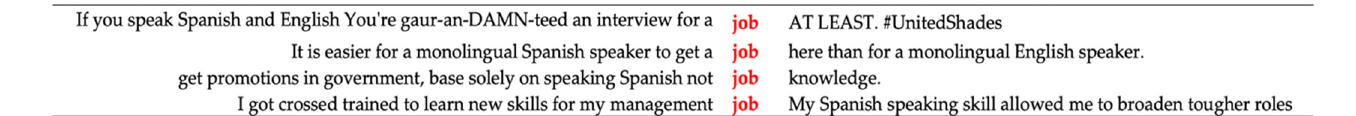
Figure 4. Concordance lines for trabajo that indicate positive attitudes on the status dimension. Figure 5. Concordance lines for trabajo that indicate negative attitudes on the status dimension. Notably, both corpora contain several frequently-occurring descriptors relating to the theme of politics—and specifically the 2020 US presidential elections—that indirectly allow us to draw conclusions regarding tweeters’ attitudes toward Spanish on the status dimension (see Table 1). These terms (e.g., election/elecciones , voters/votantes , and voting/vo- tación ) are relevant in this context because they make reference to the role that Spanish plays in politicians’ (re-)election by Floridians, as illustrated by the concordance lines in Figure 6. Figure 6. Concordance lines for vote that illustrate the role of Spanish in politicians’ (re-)election. Florida is one of the so-called battleground states— that is, those states in which even a small number of votes can determine the outcome of the elections. As the quotes from some tweeters in our corpora illustrate, the Spanish language is seen to play a role in the voting decisions made by Spanish speakers, and the use of Spanish is found to be crucial in at- tracting more voters toward presidential candidates. For instance, the first tweet below shows that political parties that conduct more outreach toward Latinx groups have a higher likelihood of getting votes from those communities, contributing to their electoral success. The tweet indicates that without their support, the election results could poten- tially change, thus indirectly demonstrating positive attitudes toward Spanish on the sta- tus dimension: “Because Trump is beating Biden with the Hispanic vote and 3/4 with Spanish speaking voters (did the poll in Spanish) Democrats made another stupid move and made Bush Republican Anna Navarro their Latino outreach. Democrats need to do better if they want to win.” The same theme is present in the tweet below, which is taken from our Spanish corpus: “Trump se encuentra en el sur de Florida en busca del voto latino, uno de los bloques de votantes más importantes del estado https …” (Trump finds himself in South Florida looking for the Latin vote, one of the most important blocks of voters in the state https …)